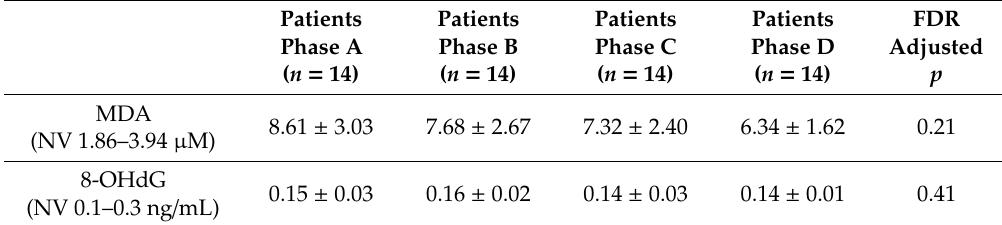
Table 5. Plasma concentrations of malondialdehyde (MDA; µ M) and 8-hydroxy-2’-deoxyguanosine (8-OHdG; ng / mL) within the patient group at each phase of chemotherapy (phase A = before; phase B = 1 month; phase C = 3 months and phase D = at the end of the chemotherapy cycle—6